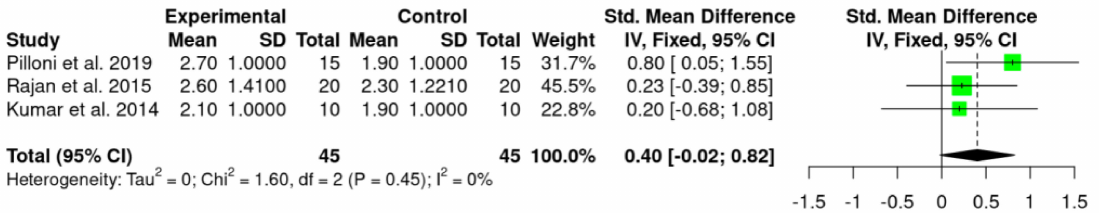
Figure 3. Forest plot with respect to the primary outcome